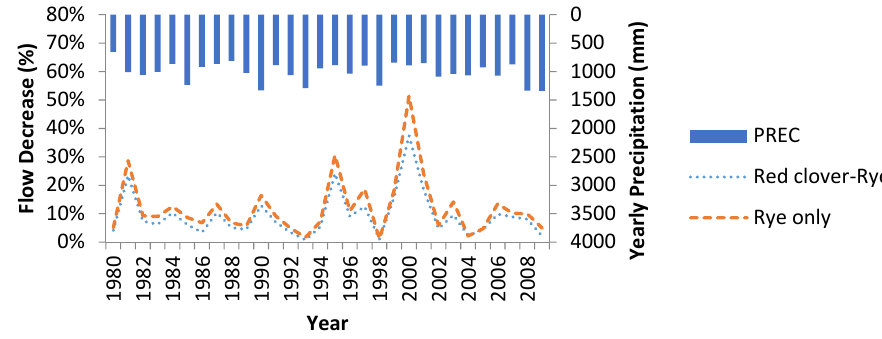
Figure 9. Decrease in flow discharge at outlet compared with no cover crop scenario.